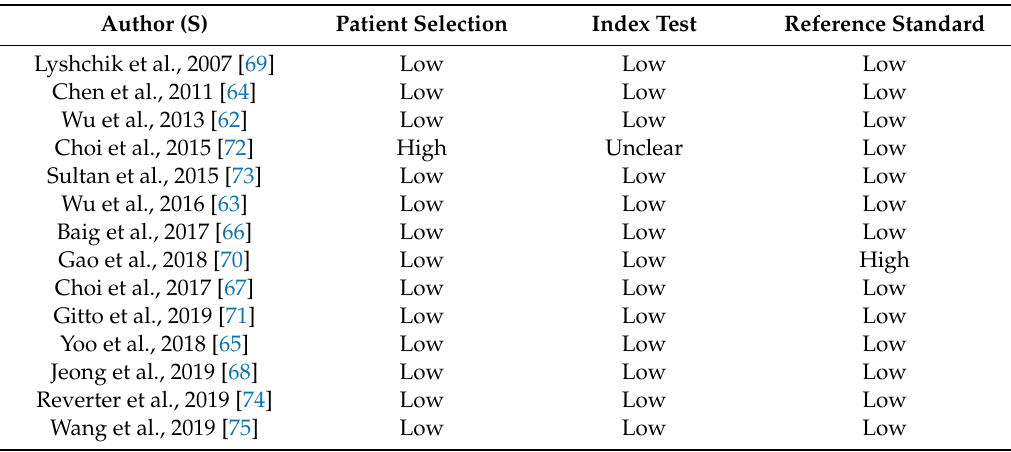
Table 5. QUADAS Applicability